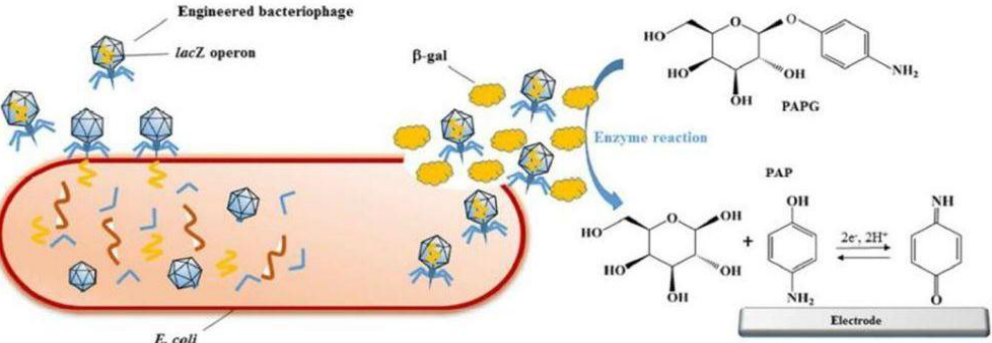
Figure 8. Schematic representation of the electrochemical detection of E. coli using engineered phages. Specific capture and infection of E. coli by T7lacZ phage resulted in the release and overexpression of β -galactosidase. PAPG was catalyzed by β -galactosidase into PAP which can be quantified with the electrochemical device. Reproduced in part from [115], with permission from ACS.